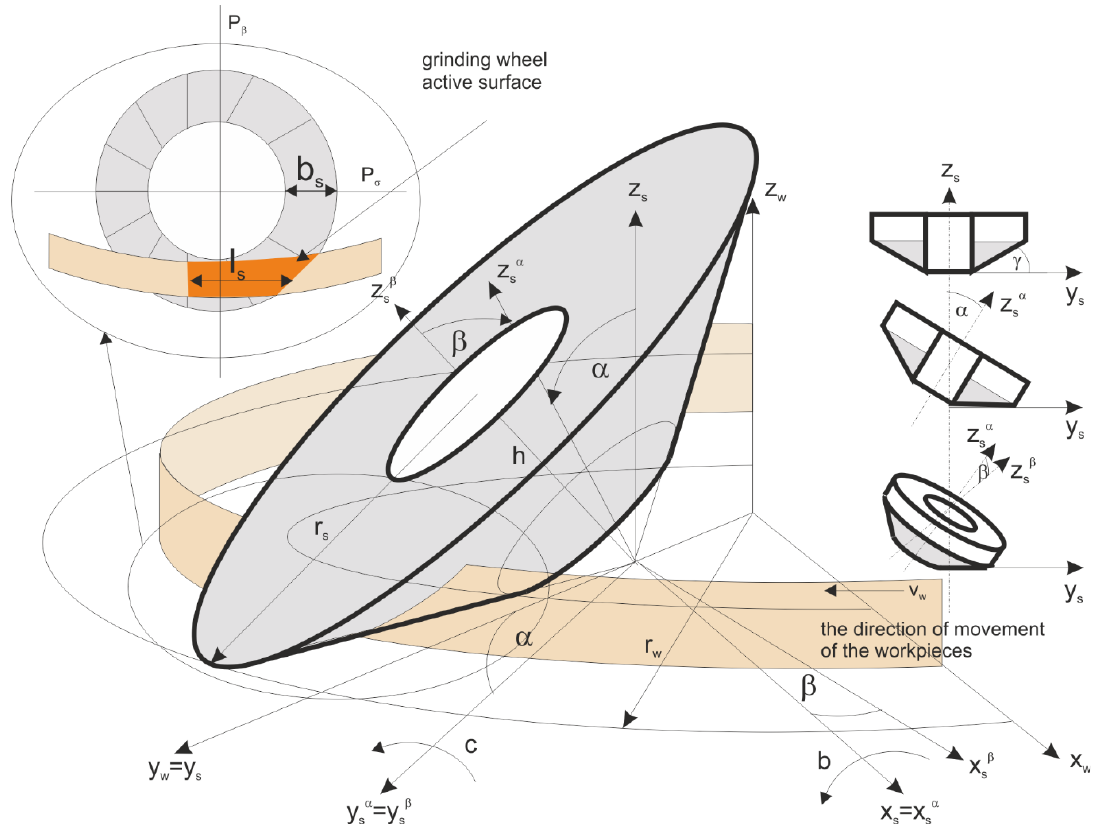
Figure 1. The geometric parameters of the performed grinding method.